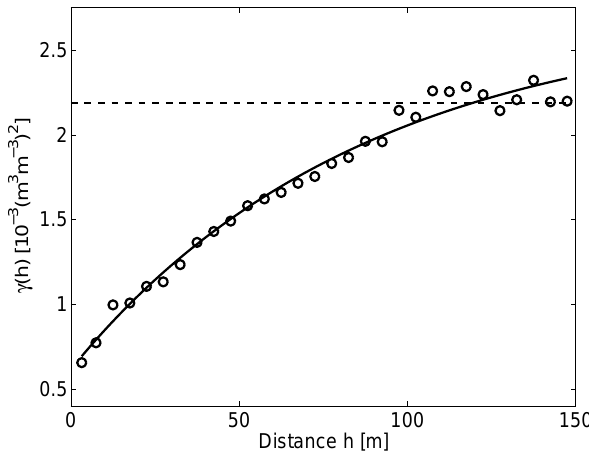
Fig. 3. Variogram of soil moisture computed for the field campaign in Marbaix, 15 April 2009 with a class distance from 0 to 150m by a step of 5m. A variogram using an exponential model is fitted on the data. The total variance of soil moisture is depicted with the dashed